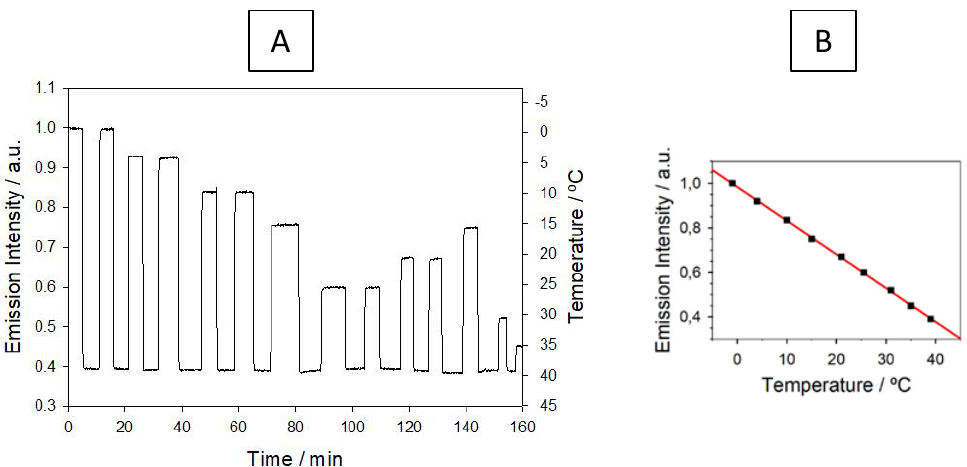
Figure 4. Response of the luminescent temperature sensor containing [Ru(phen) 2 (4-Clp)] 2+ immobilized into poly(ethyl cyanoacrylate). ( A ) Real-time response; ( B ) Calibration plot.